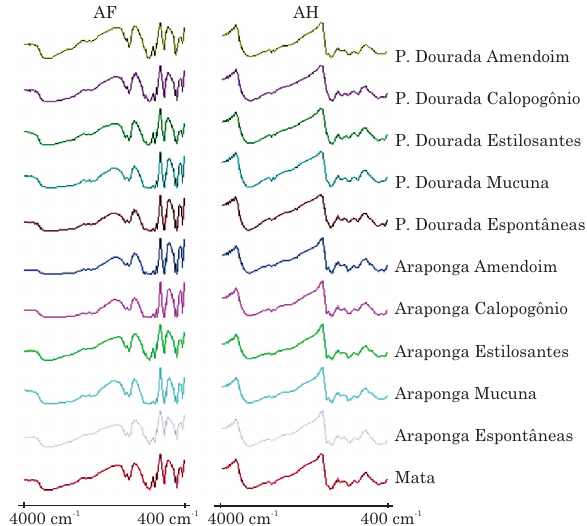
Figura 3. Espectros na região do infravermelho de ácidos fúlvicos e húmicos isolados de solos sob adubação verde e espécies espontâneas, em duas propriedades com diferentes condições